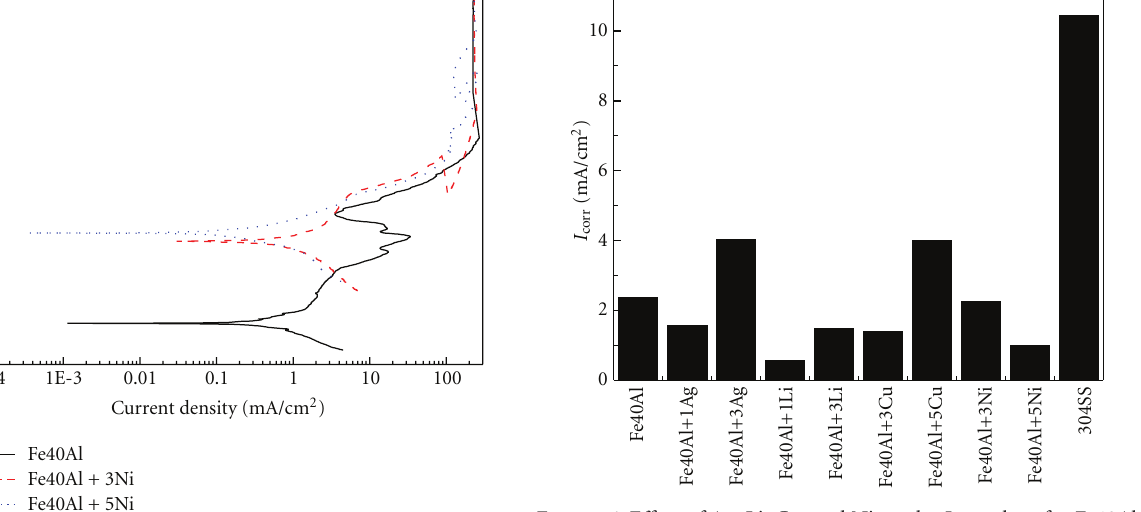
Figure 6: E ff ect of Ag, Li, Cu, and Ni on the I corr values for Fe40Al alloy in NaCl-KCl (1: 1 molar ratio) deposit in static air at 670 ◦